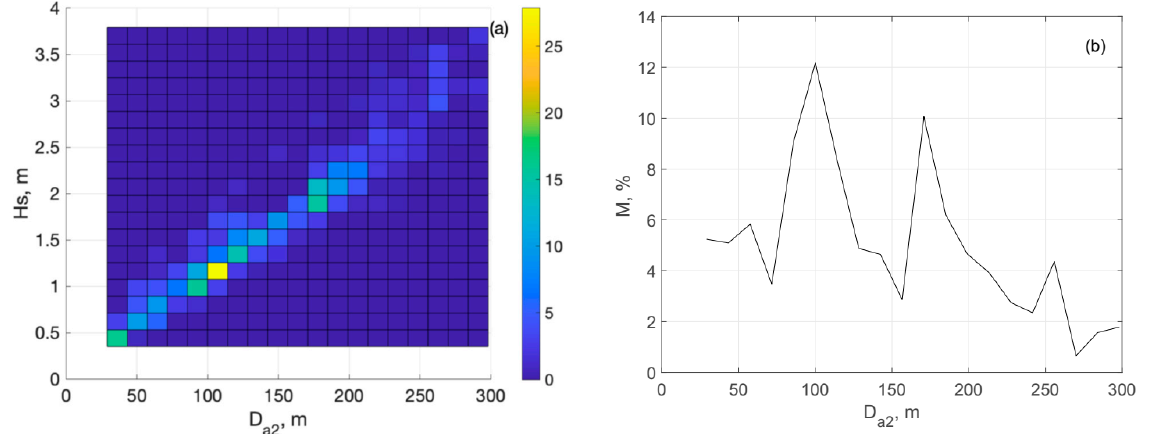
Figure 6. ( a ) Bivariate histogram depending on the value of the second harmonic maximum distance off the shoreline weighted by the dimensionless relation between the significant wave height and the depth of the second harmonic maximum; ( b ) wave impact metric (Equation (6)) in dependence on the distance from the second harmonic maximum to the